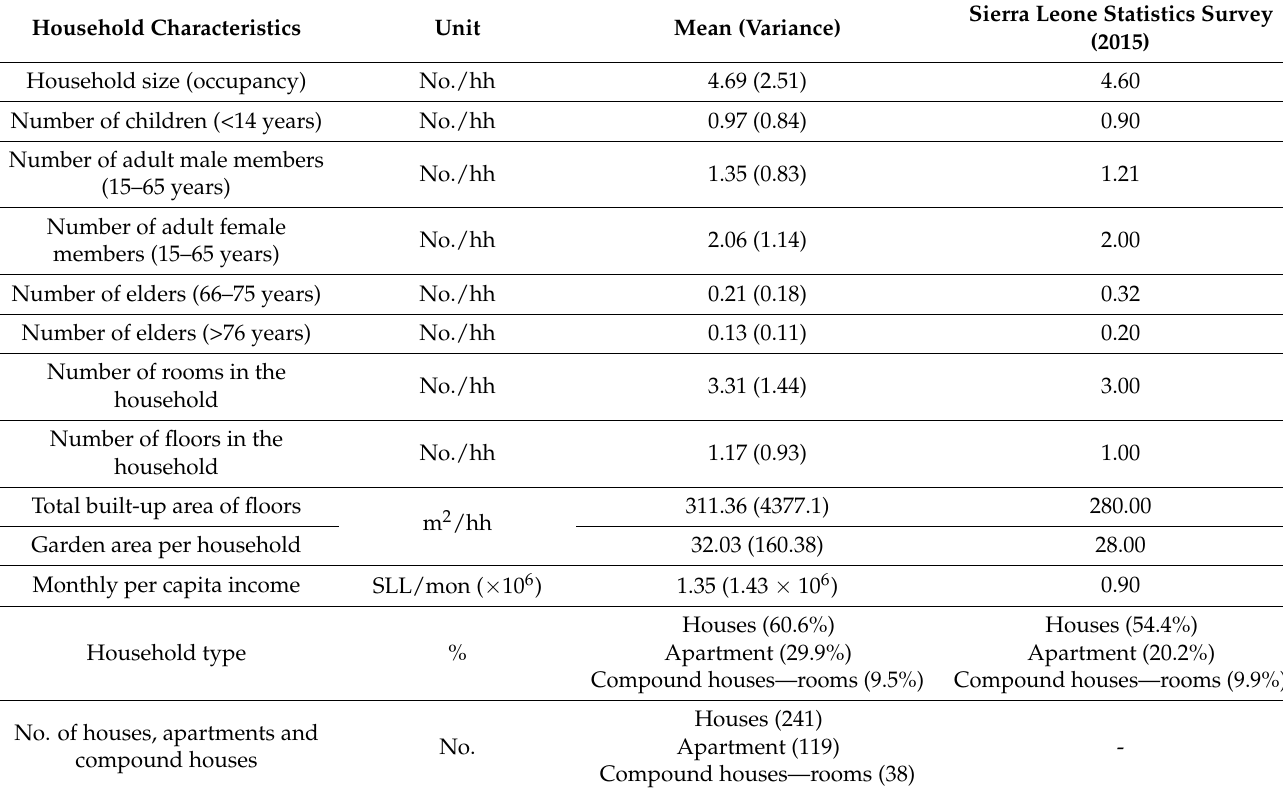
Table 2. Summary of statistical parameters of household characteristics for the whole survey (398